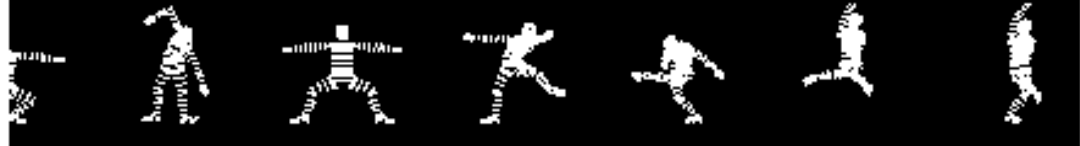
Figure 4.11. Sequence created learning to use